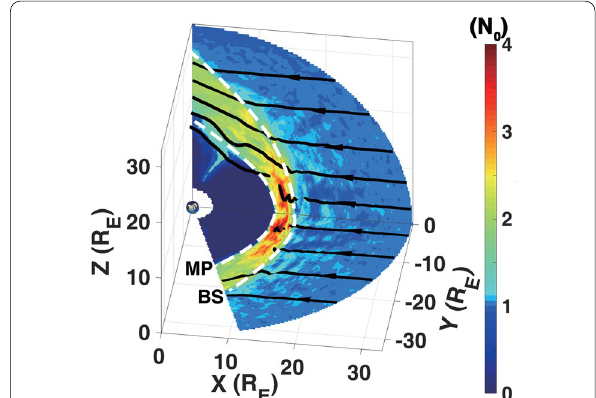
100 (cid:31) − 1 i 0 in the noon-meridian Fig. 12 Case II global view of N at t = and equatorial planes, showing the 3-D structures of the global system. The white dashed lines roughly mark the magnetopause and bow shock positions, respectively, and typical magnetic field lines are also displayed. The foreshock disturbances and the magnetosheath density are much weaker compared with Case